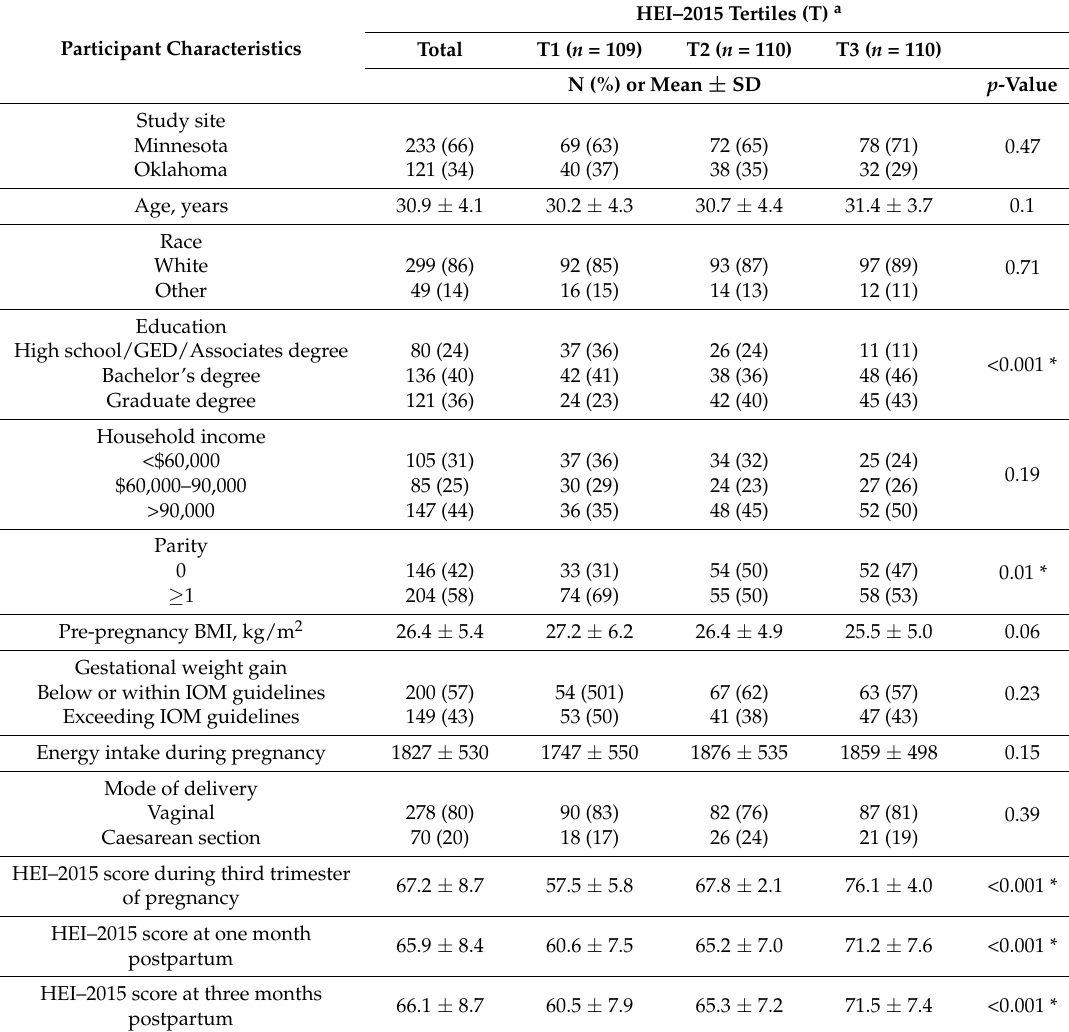
Table 1. Participant demographic and clinical characteristics by tertiles of maternal HEI–2015 total scores during the third trimester of pregnancy ( n =